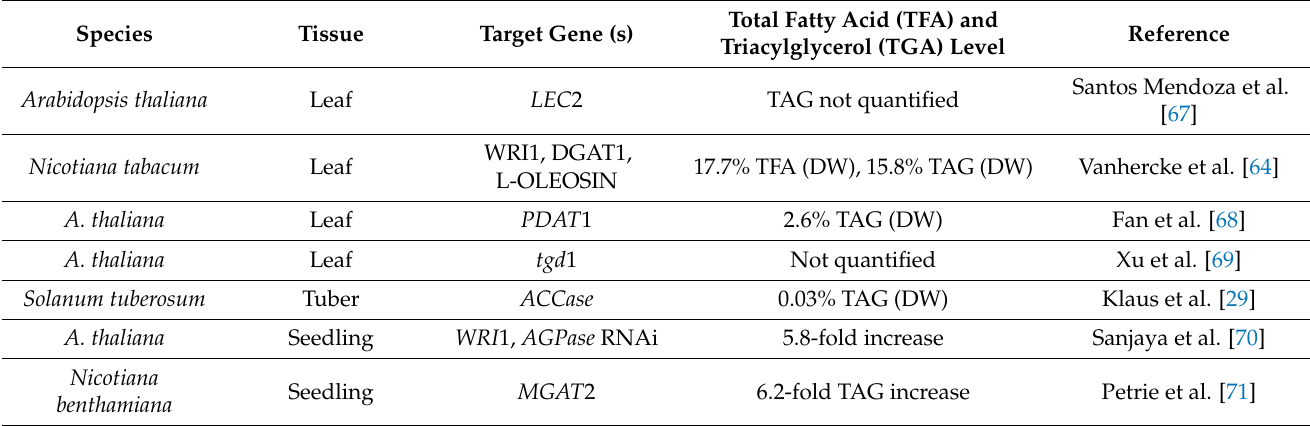
Table 1. Details of targeted genes responsible for the increase in the lipid content in the plant’s vegetative tissues.